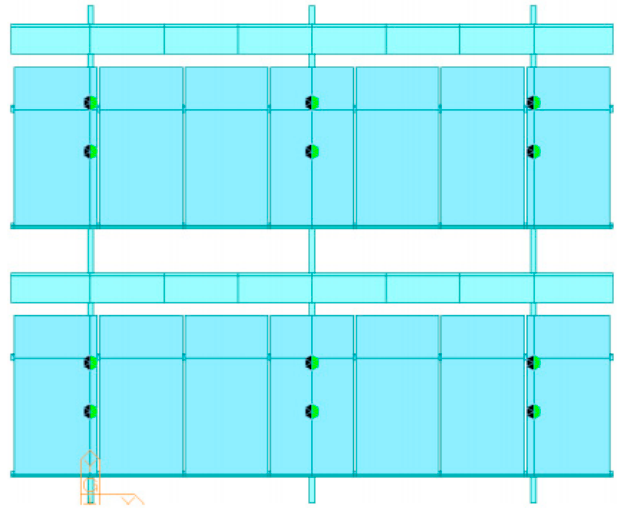
Figure 11. Boundary conditions . Table 3. Wind load variables.